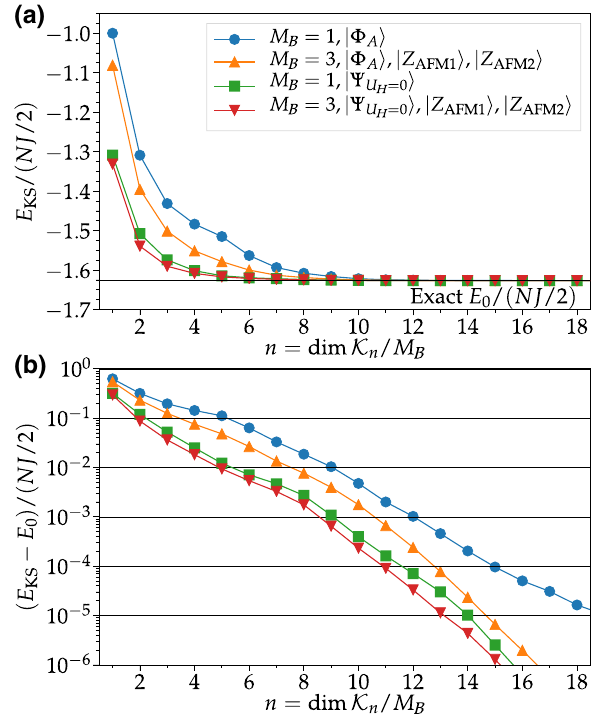
FIG. 14. Same as Fig. 5 but for the Fermi-Hubbard model with U H / J = 4 at half